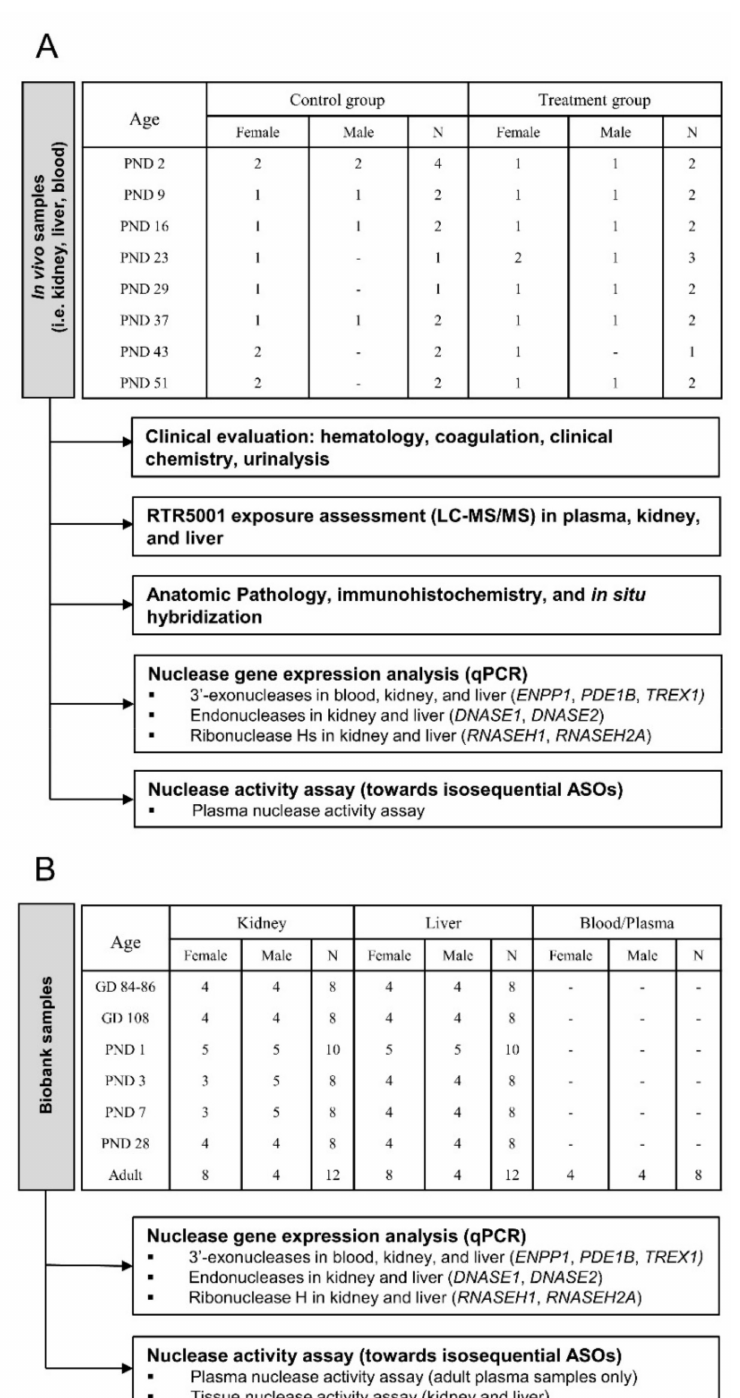
Figure 1. Schematic diagram of the study design illustrating the samples used and main experi- mental approaches. ( A ) In vivo study sample distribution over the different developmental stages, experimental groups, and sex. ( B ) Biobank study sample distribution over different juvenile and adult stages, and sex. Downstream usage of samples for the different assays are represented by arrows. GD: gestational day; PND: postnatal day; qPCR: quantitative polymerase chain reaction; ENPP1 : ectonucleotide pyrophosphatase/phosphodiesterase 1; PDE1B : Phosphodiesterase 1B; TREX1 : three-prime repair exonuclease 1; DNASE1 and DNASE2 : deoxyribonuclease 1 and 2; RNASEH1 and RNASEH2A : ribonuclease H 1 and 2 subunit A; LC-MS/MS: liquid chromatography coupled with tandem mass